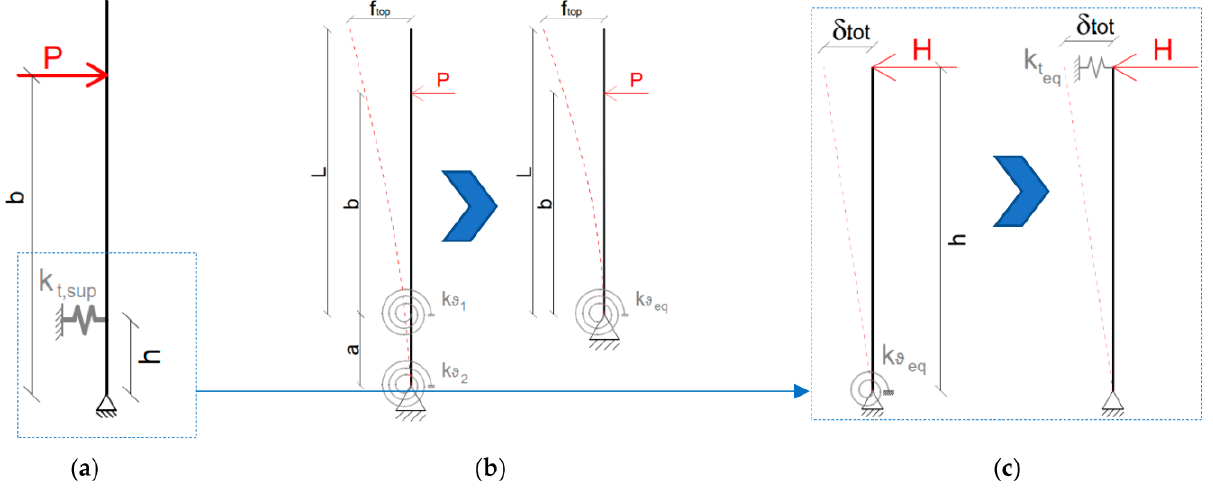
Figure 11. Derivation of equivalent stiffness parameters, as for the SM2 simplified model: ( a ) required translational stiffness, with ( b ) equivalent rotational and ( c ) translational terms.